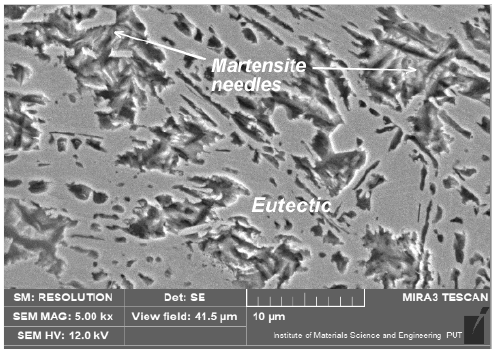
Figure 14. Microstructure of nodular cast iron surface layer, after laser alloying with silicon nitride (scanning electron microscope, etched with nital 3%).